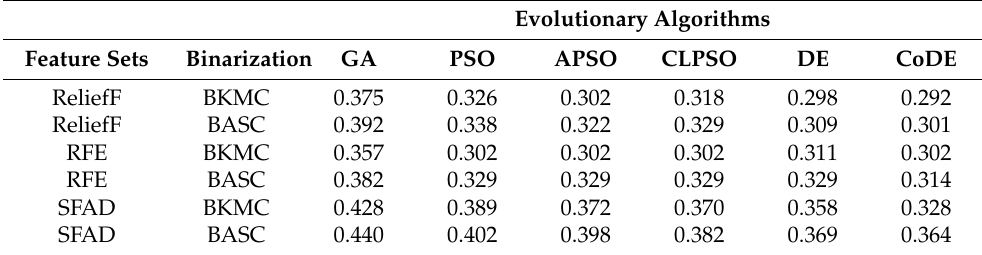
Table 4. Maximum individual fitness (individuals with smallest surface roughness) in terminating generation.